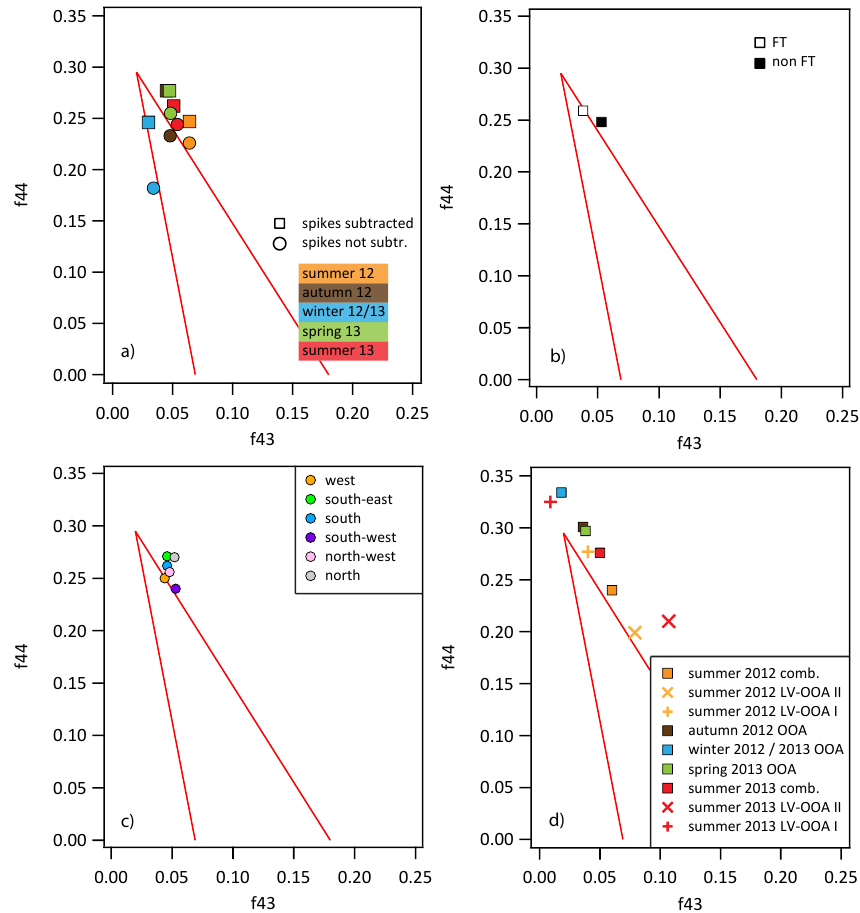
Figure 10. f 44 vs. f 43 plots for different boundary conditions. The triangular space in between the red lines is the region in the f 44 /f 43 space described by Ng et al. (2010), where atmospheric AMS data typically show up. (a) Separation by seasons: summer 2012 (orange), autumn 2012 (brown), winter 2012/2013 (blue), spring 2013 (green), summer 2013 (red). Circles show f 44 and f 43 calculated from the full data set and squares show f 44 and f 43 after subtraction of local OA (POA loc ; see Sect. 3.2.1). (b) Separation by air masses (using NO y / CO; see Sect. 2.5): free tropospheric air masses (white square); boundary layer-influenced air masses (black square). (c) Separation by air mass origin (using the clusters described in Sect. 2.4 and shown in Fig. 5): west (orange), south-east (light green), south (blue), south-west (violet), north-west (pink), north (grey). (d) Location of OOA factors from Sect. 3.2.1 in f 44 vs. f 43 triangle. In summer two OOAs were found, both and the combination are shown in the